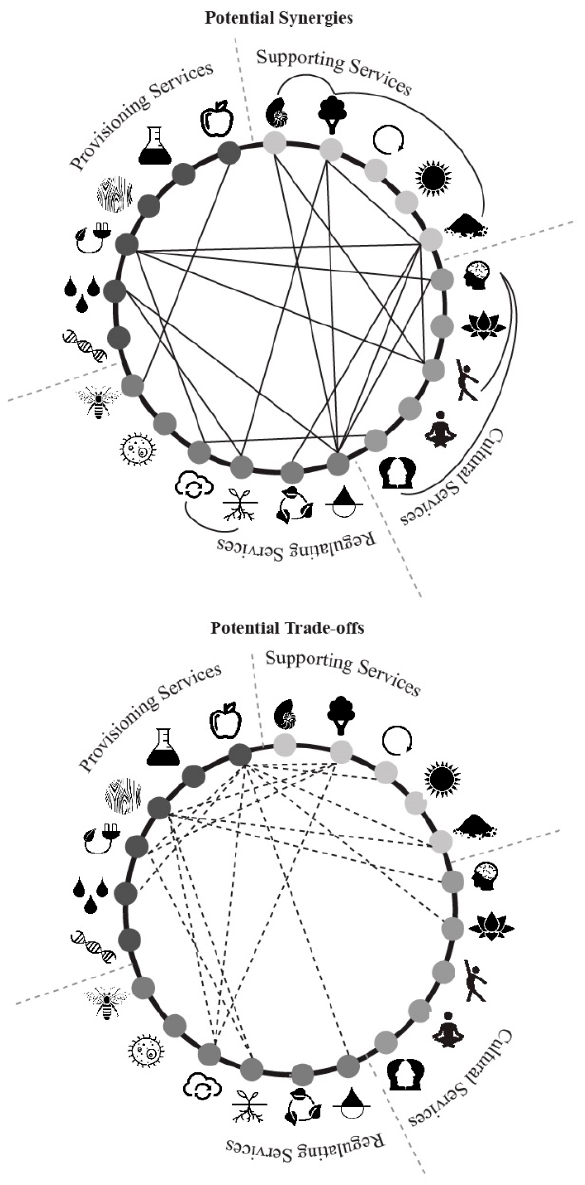
Figure 1. Potential synergies and trade-o ff relationships between ecosystem services. Source: [49]. See Table 1 for icon key.